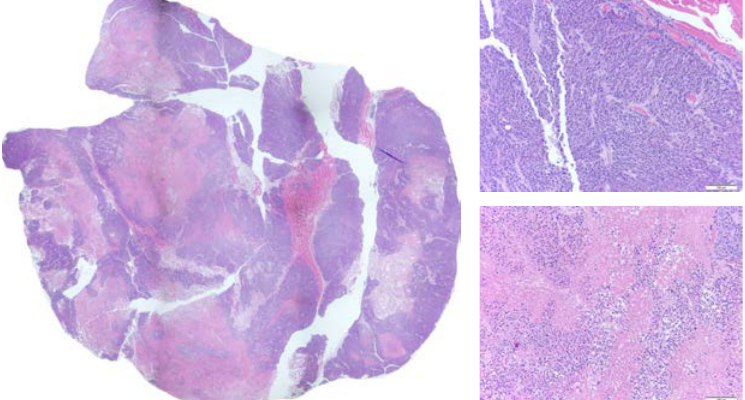
Fig. 7. H&E staining for the p53 (cid:1) = (cid:1) tumor in Fig. 4. Photo-stitched whole tissue section (L), typical tumor rim (top right, 20X) and typical tumor center (bottom right, 20X).